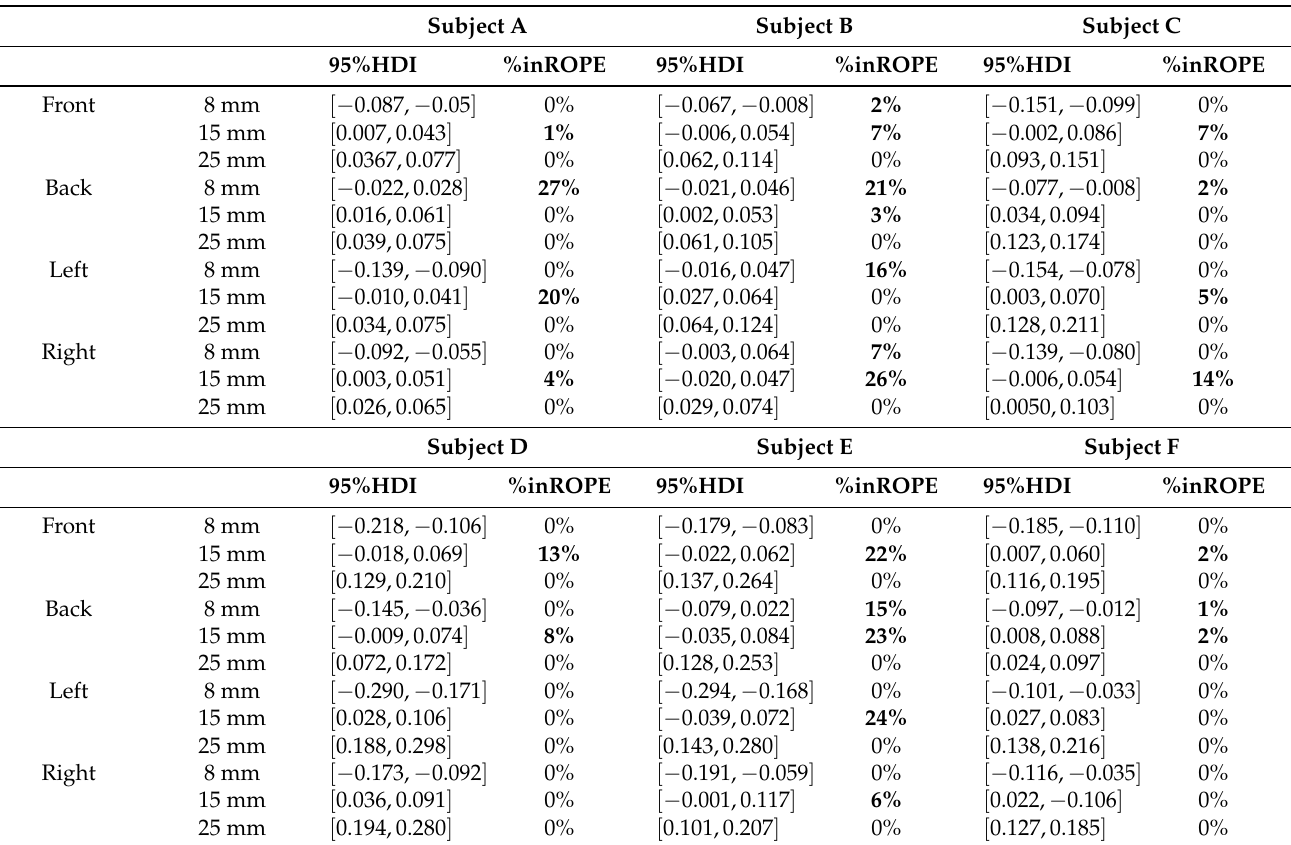
Table 5. Bayesian statistics results for the difference between the mean of the measured and model movement duration for all subjects. The 95% HDI (highest density interval) is an interval which the true value of parameter exist with 95% probability. In this case, we focus on whether the 95% HDI contains zeros. ROPE (region of practical equivalence) was set to [ − 0.1,0.1 ] . %inROPE means the percentage of the posterior probability mass within the ROPE. The bold text denotes ≥